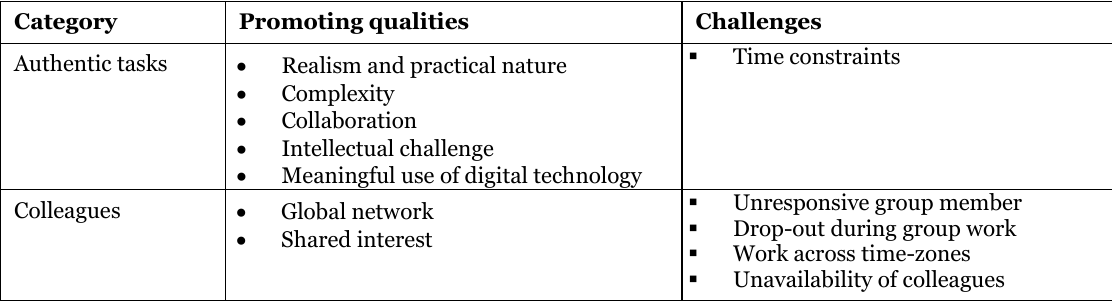
Elements That Promote/Impede Learning